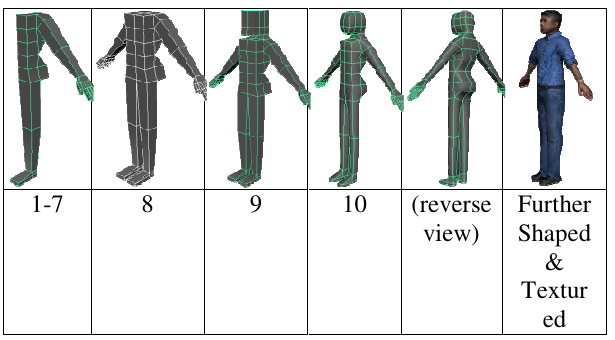
Figure 7. Attaching the Body Parts (see text for Attaching the Body Parts (see text